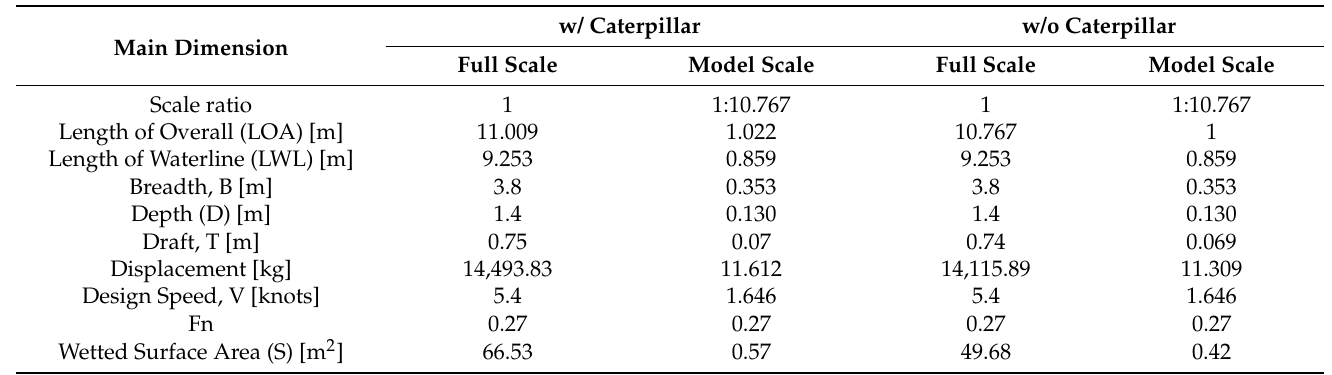
Table 1. Main dimensions of the vessels.